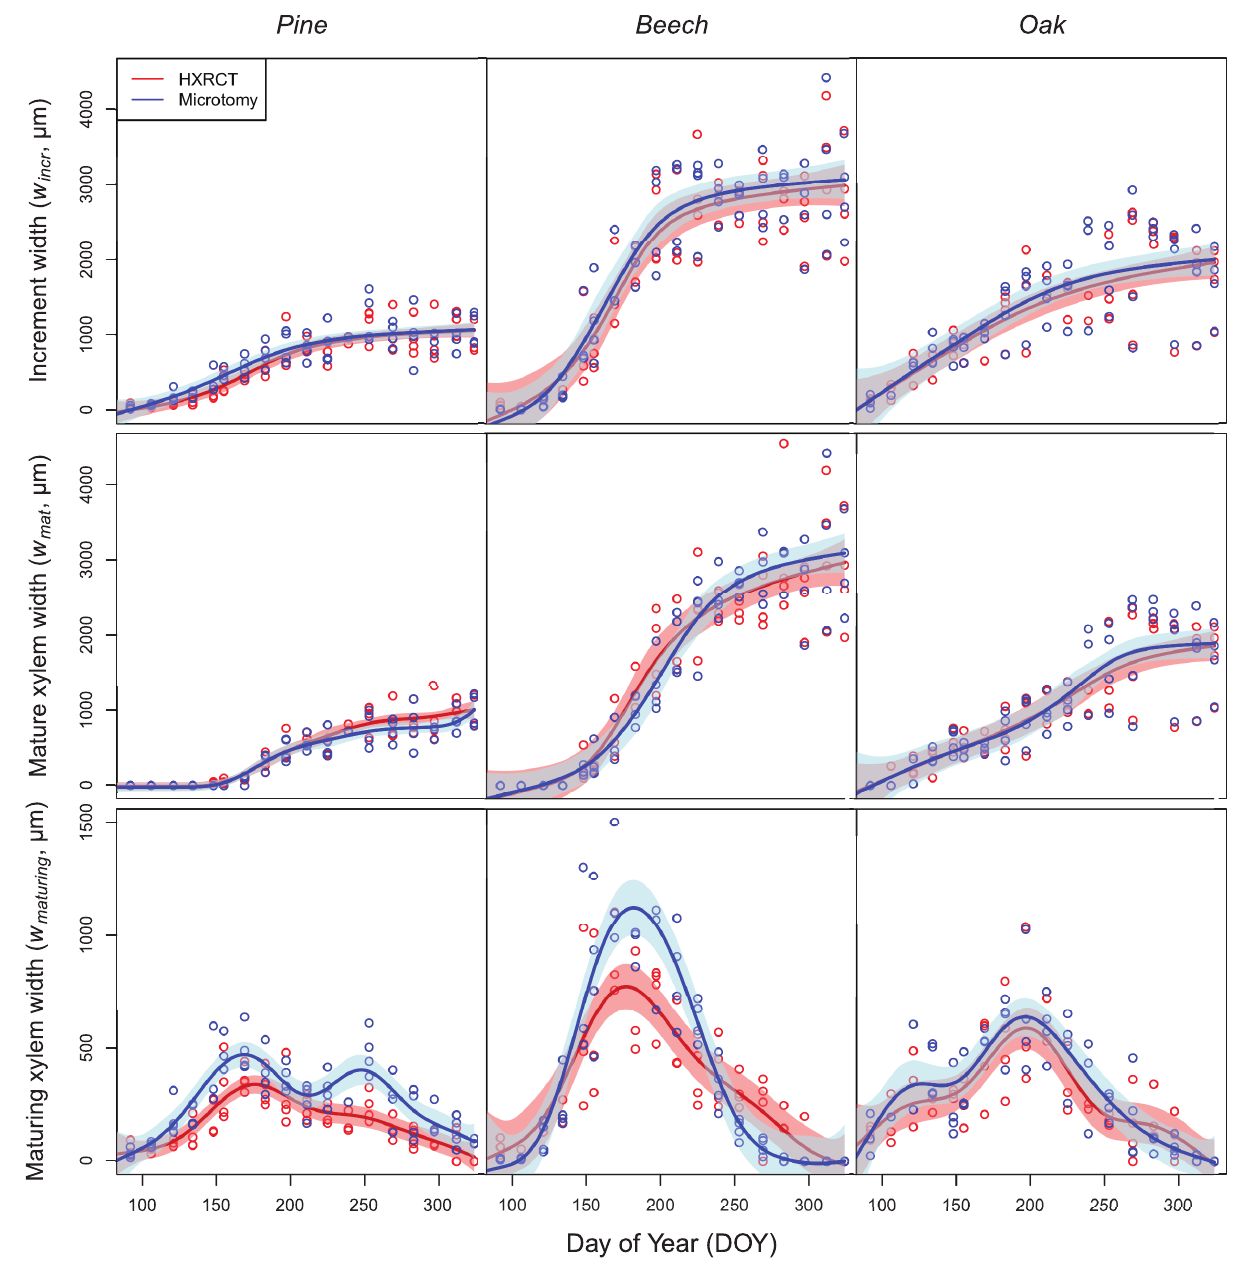
FIGURE 6 | Seasonal growth pattern assessed with HXRCT (red) and microtomy (blue). Variations of increment and mature xylem were fitted with constrained GAMs (top and middle row), while maturing xylem width was fitted with unconstrained GAMs (bottom row). The shaded band represents the standard error of the